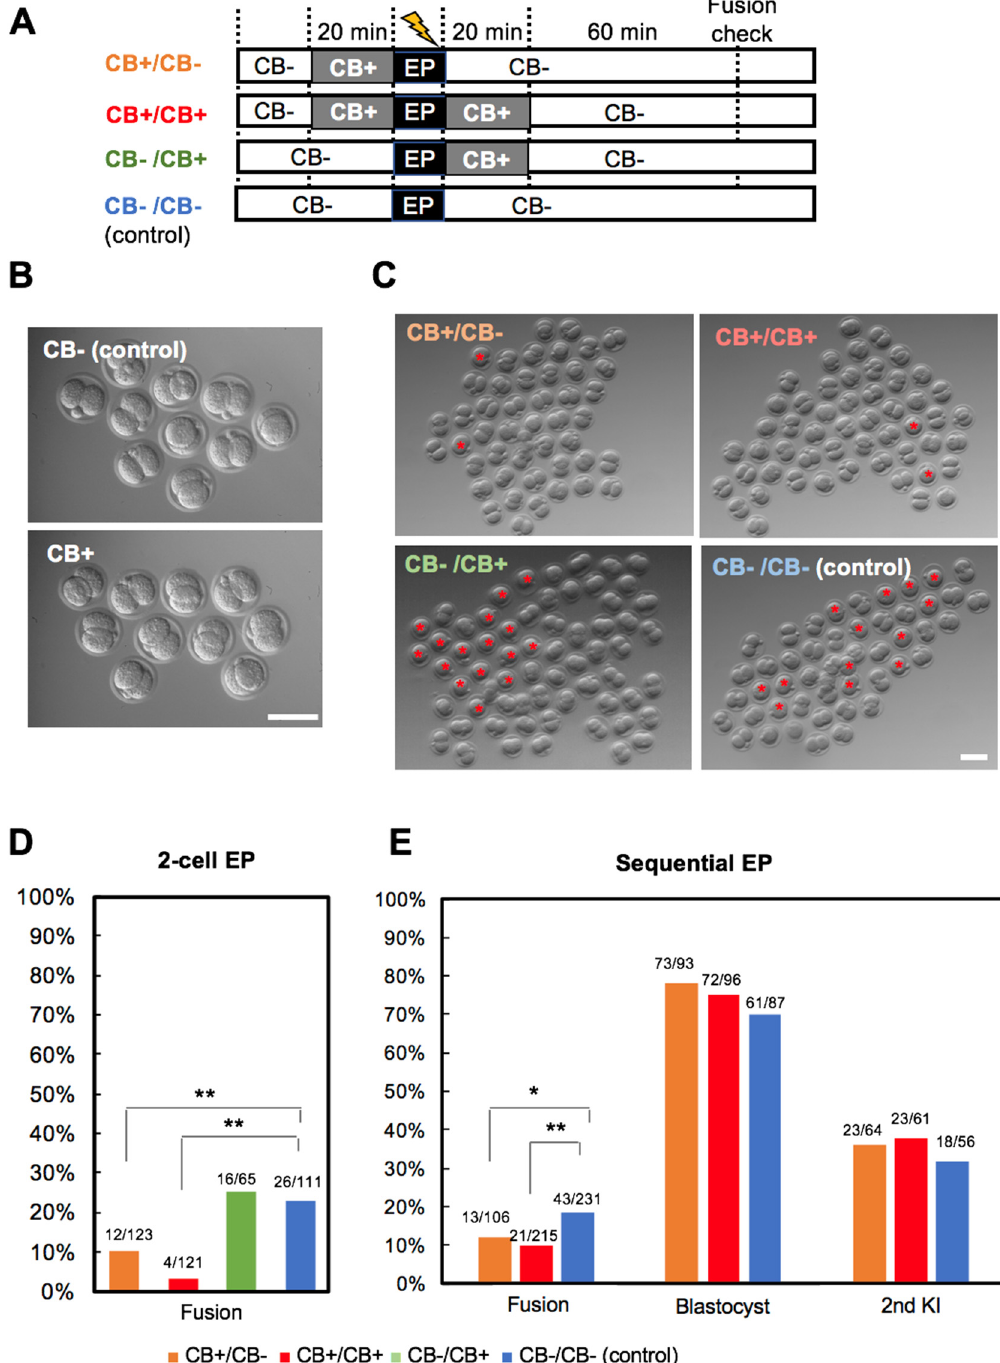
Figure 4. Effects of CB treatment on blastomere fusion, embryonic development and KI efficiency in vitro. ( A ) Experimental timeline of CB treatment. ( B ) Morphology of 2-cell stage embryos (B6D2F1) after 20 min treatment of CB (5 μ g/mL). ( C ) Morphology of 2-cell EP embryos. Asterisks indicate fused embryos. ( D ) Fusion rate of 2-cell EP embryos. ( E ) Fusion rate, development (blastocyst) rate, and KI efficiency after sequential EP. * p < 0.05, ** p < 0.01. Scale bars, 100 μ m.